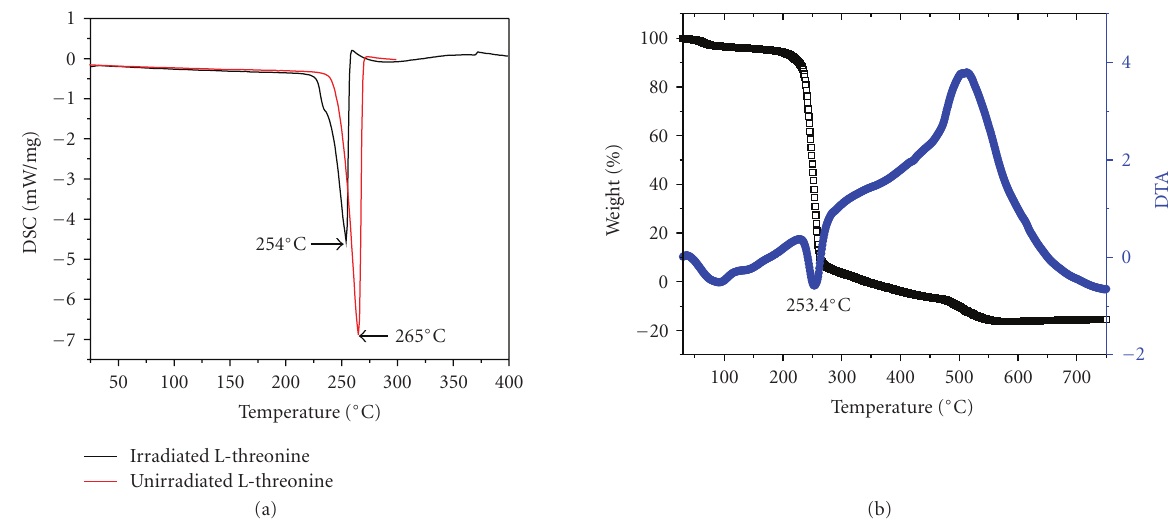
Figure 49: (a) DSC curves of unirradiated and electron-irradiated L-threonine crystal at 12 × 10 14 e/cm 2 . (b) simultaneous TGA-DTA curve for electron-irradiated L-threonine.